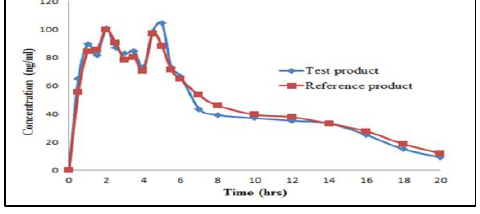
Figure (1): Mean plasma concentrations of pentoxifylline versus time after a single dose administration of a test formulation (extended- release tablet containing 400 mg pentoxifylline) and the reference formulation (Trental ® extended-release tablet containing 400 mg pentoxifylline) to 32 healthy male adult subjects under fasting condition.